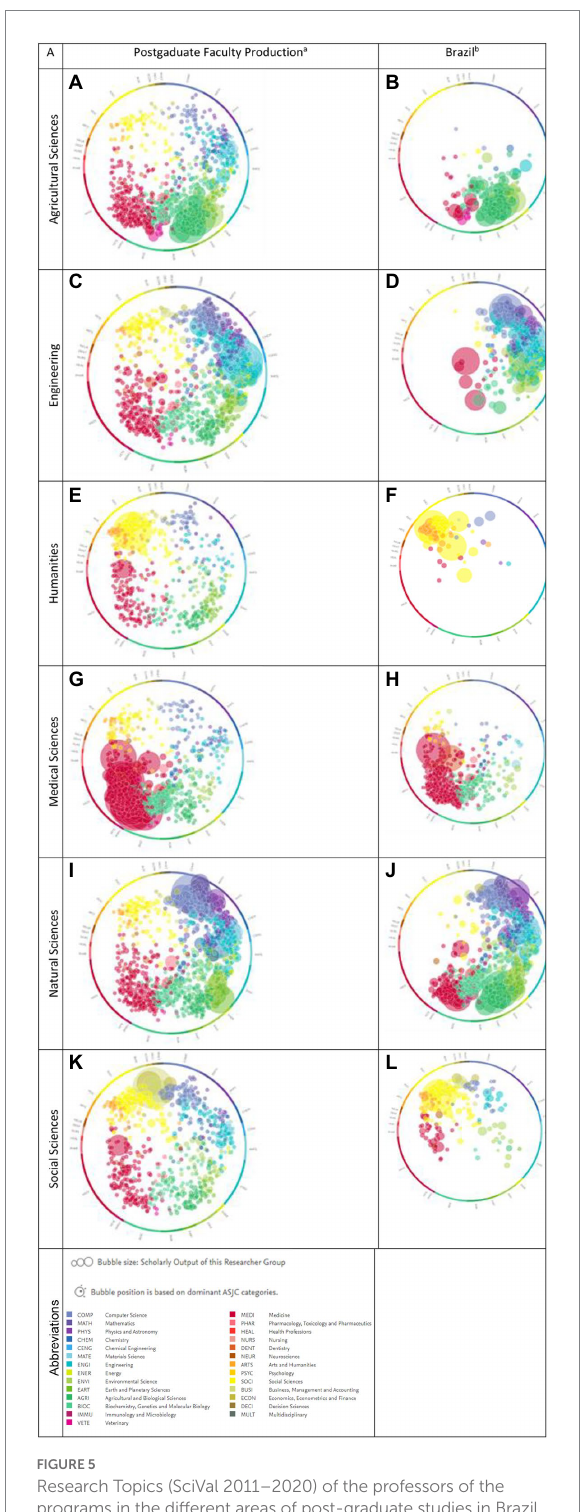
FIGURE 5 Research Topics (SciVal 2011–2020) of the professors of the programs in the different areas of post-graduate studies in Brazil (first column) and the topics of researchers from Brazil (second column) in the different areas of knowledge. a Areas of knowledge where the professors of the Postgraduate Programs of the Major areas indicated publish their papers. b Publications from Brazil in Journals classified in the indicated area of knowledge (FORD- Fields of Research and Development Classification – Frascati Manual of the